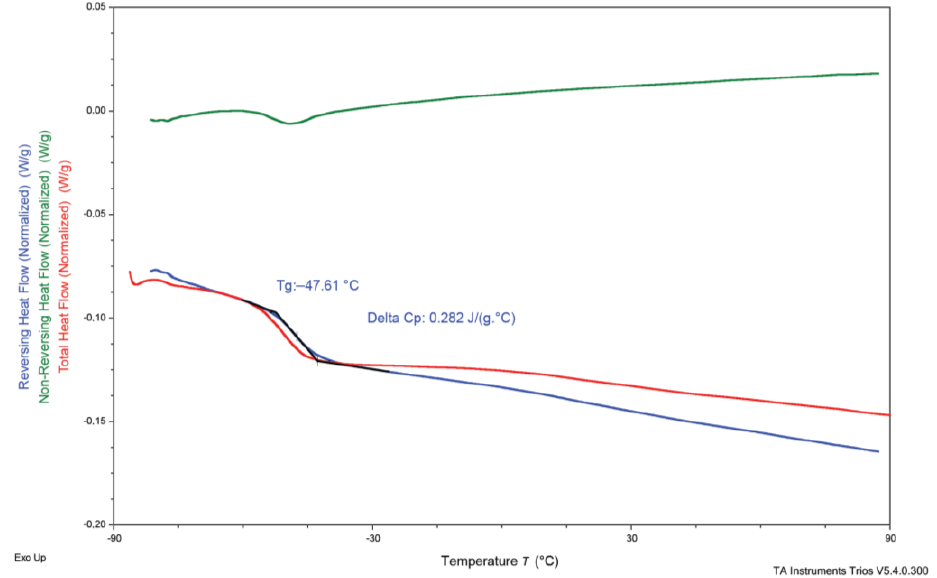
Figure 6. DSC thermogram of the crosslinked material.